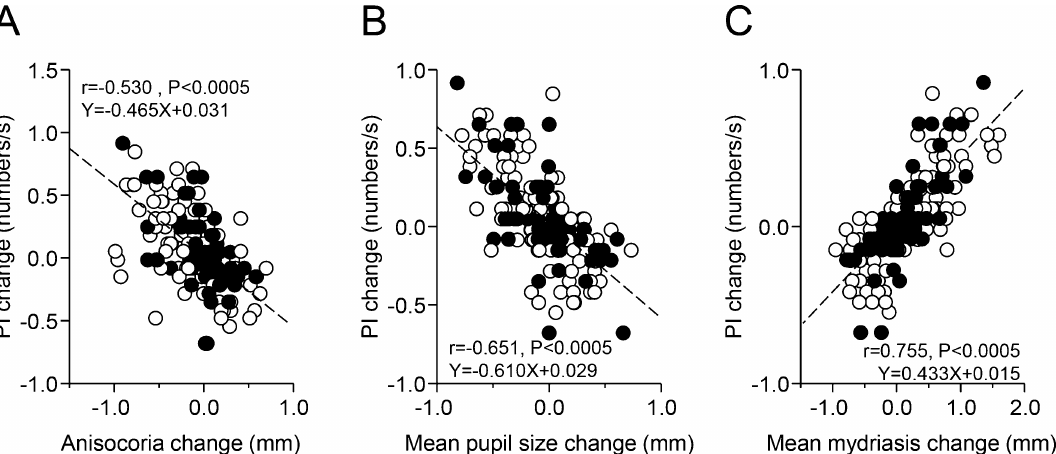
Figure 6. Relation between the changes in PI and those in average pupil size at rest, task-related mydriasis and anisocoria induced by modifying arches position and occlusal condition. Values of PI changes have been plotted as a function of the corresponding changes in average pupil size (A) , anisocoria (B) and task-related mydriasis (C) . The dotted lines represent regression lines of all the plotted points, whose equations have been reported in the graphs. Dots and circles refer to TMJ disorders/edentulous and normal subjects, respectively.